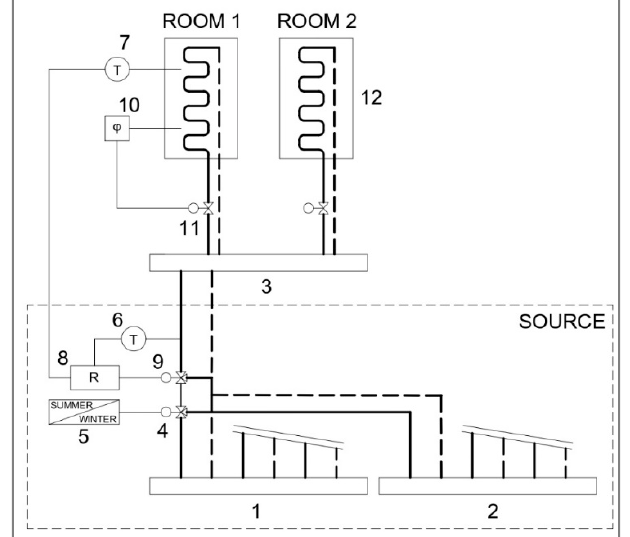
Figure 5. Continuous control of the heating/cooling water supply temperature according to the tem